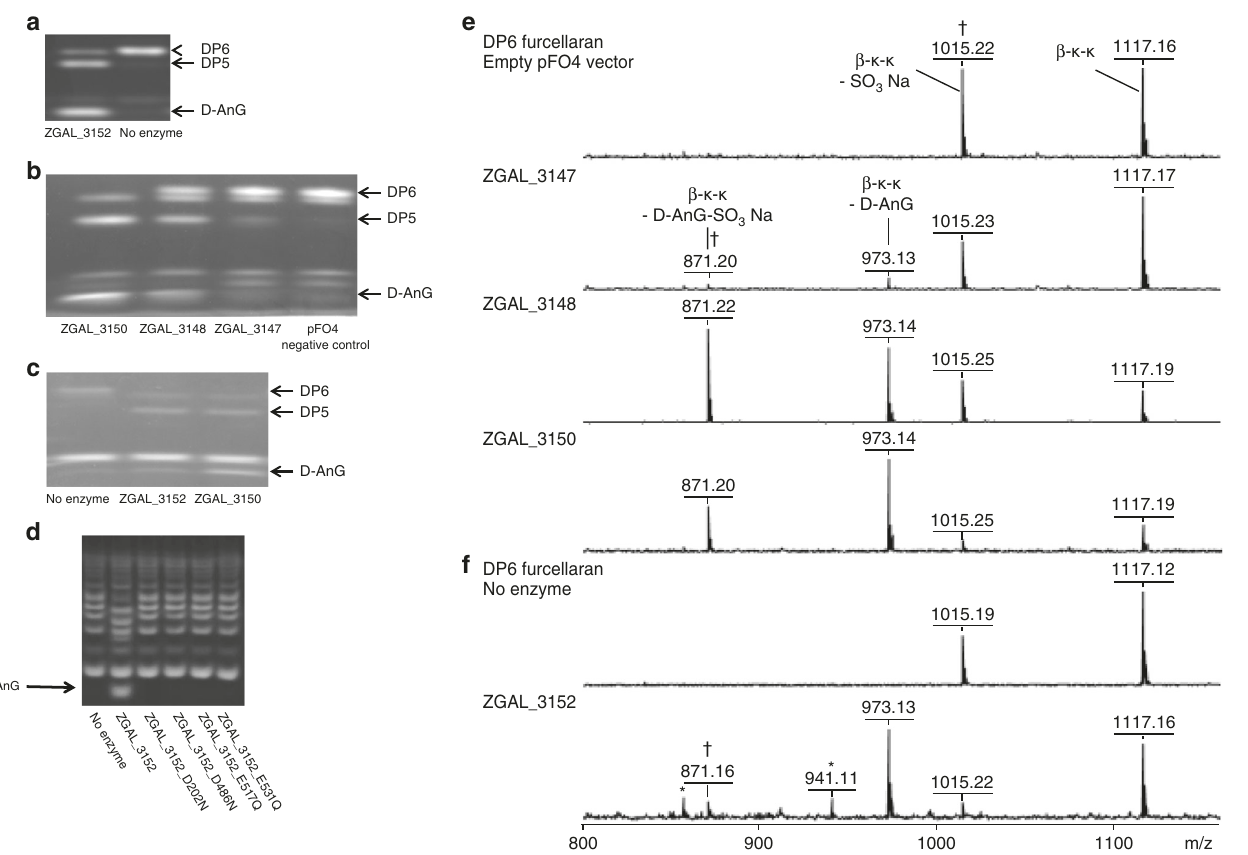
Fig. 2 Biochemical characterization of the GH127 and GH129-like enzymes. GH127 enzymes (DagA1, DagA2, DagA3; ZGAL_3147, ZGAL_3148, ZGAL_3150) and GH129-like enzymes (DagB, ZGAL_3152). a FACE gel depicting the reaction products after furcellaran (beta-carrageenan) oligosaccharides were treated with pure ZGAL_3152. b FACE gel depicting the reaction products after furcellaran oligosaccharides were treated with soluble lysate of E. coli BL21 (DE3) that were transformed with the pFO4 vector alone (negative control) or with the genes of interest cloned into the pFO4 vector c FACE gels depicting the reaction products after furcellaran oligosaccharides were treated with IMAC-puri fi ed ZGAL_3152 and ZGAL_3150. d FACE gels depicting the reaction products after furcellaran oligosaccharides were treated with ZGAL_3152 and four conservative active site mutants. e MALDI MS spectra of the DP6 beta-kappa-kappa oligosaccharide obtained in negative ionization mode after incubation with soluble lysates of BL21(DE3) cells that were transformed with the pFO4 vector only and ZGAL_3147, ZGAL_3148, ZGAL3150. f Spectrum obtained for DP6 beta-kappa-kappa oligosaccharide incubated with no enzyme and the spectrum of the same sample after treatment with IMAC puri fi ed ZGAL_3152. Fragments annotated with a † correspond to a sulfate loss induced by the ionization process. Peaks annotated with a * correspond to HEPES adducts on matrix clusters. DP stands for degree